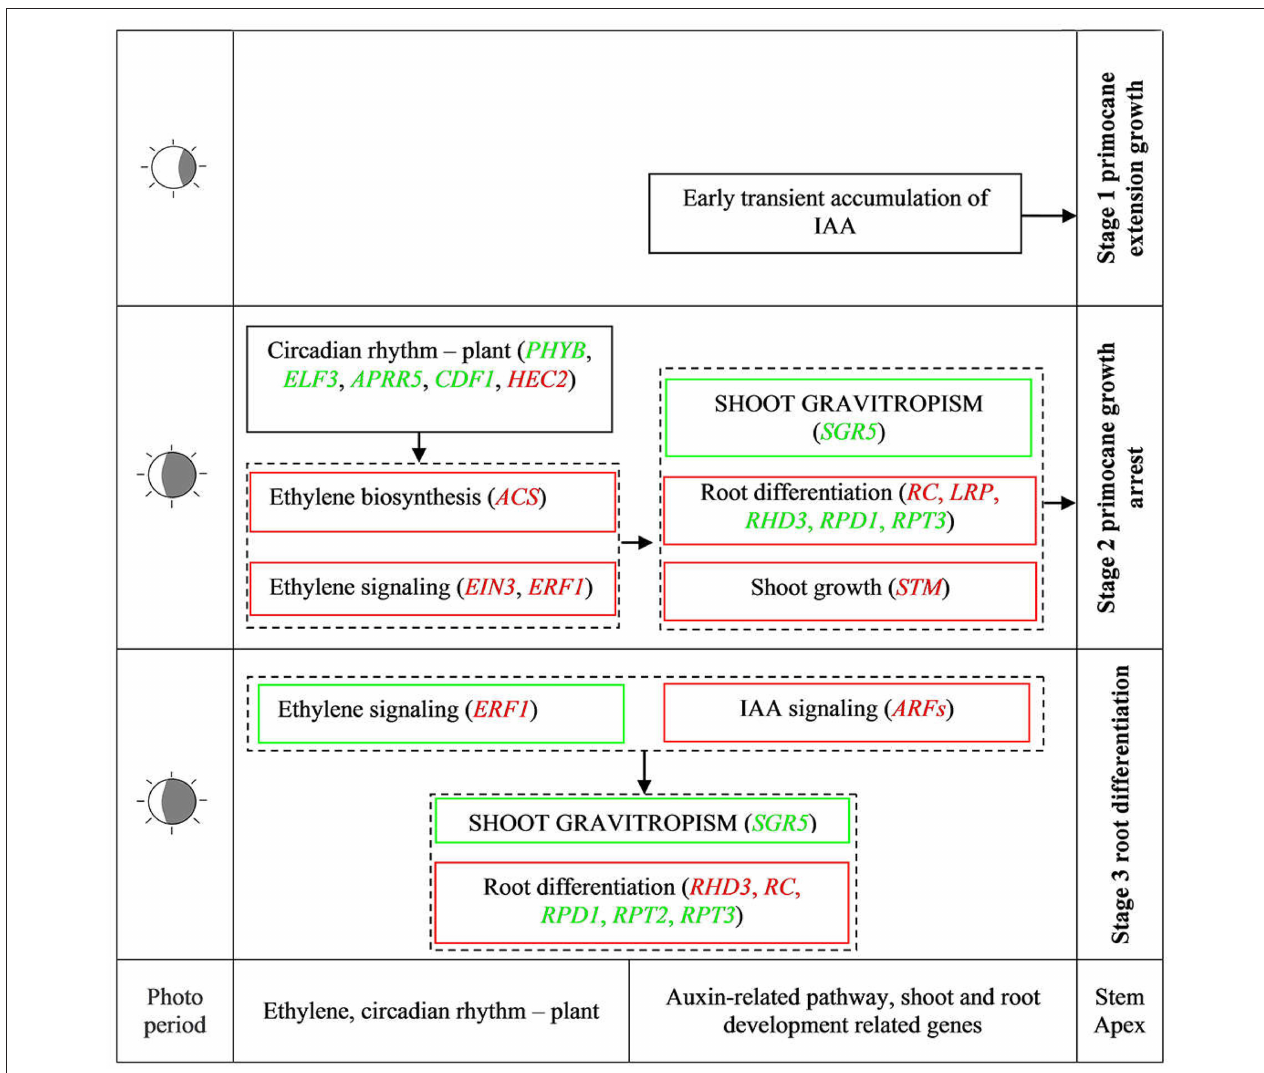
FIGURE 9 | Simple model of important physiological units of spontaneous rooting of stem apex and regulative factors controlling ethylene, auxin, ABA, and circadian rhythm in AR formation. Green and red words in square frames represent down- and up-regulated DEGs, respectively. Green and red square frames represent down and up regulation pathways, respectively. ACS, 1-Aminocyclopropane-1-Carboxylate Synthase; AIR12, Auxin Induced in Roots 12; APRR5, Two-Component Response Regulator APRR5; ARFs, Auxin Response Factors; CDF1, Cycling Dof Factor 1; CTR1, Threonine-Protein Kinase CTR1; EIN3, Ethylene-Insensitive3; ELF3, Early Flowering 3; ERF1, Ethylene-Responsive Transcription Factor1; HEC2, HECATE 2; LRP, Lateral Root Primordium; PHYB, Phytochrome B; RC, ROOT CAP; RHD3, Root Hair Defective 3; RPD1, ROOT Primordium Defective 1; RPT, Root Phototropism; SGR5, Shoot Gravitropism 5; STM, Shoot Meristemless.